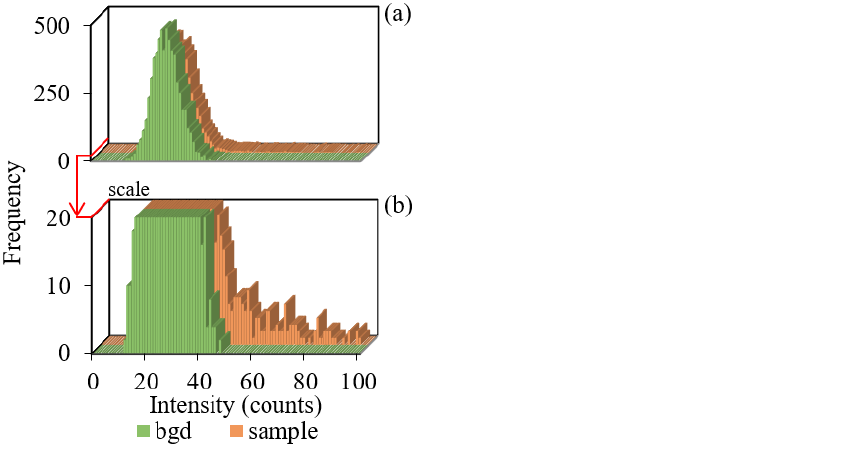
Figure 1. Signal distributions of the background and sample 3 containing TiO 2 NPs in ( a ) full and ( b ) enlarged scales.